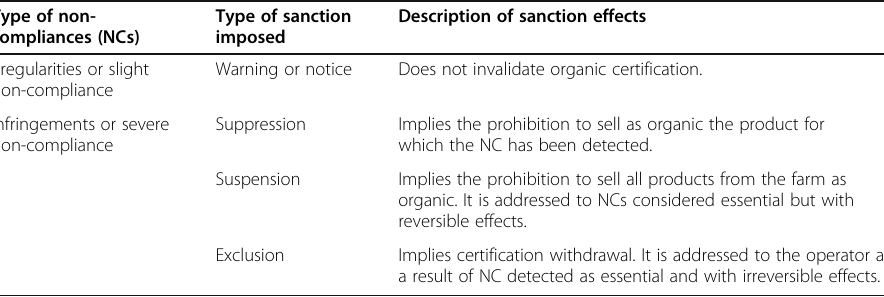
Table 2 Classification of non-compliance and sanctions Type of non- compliances